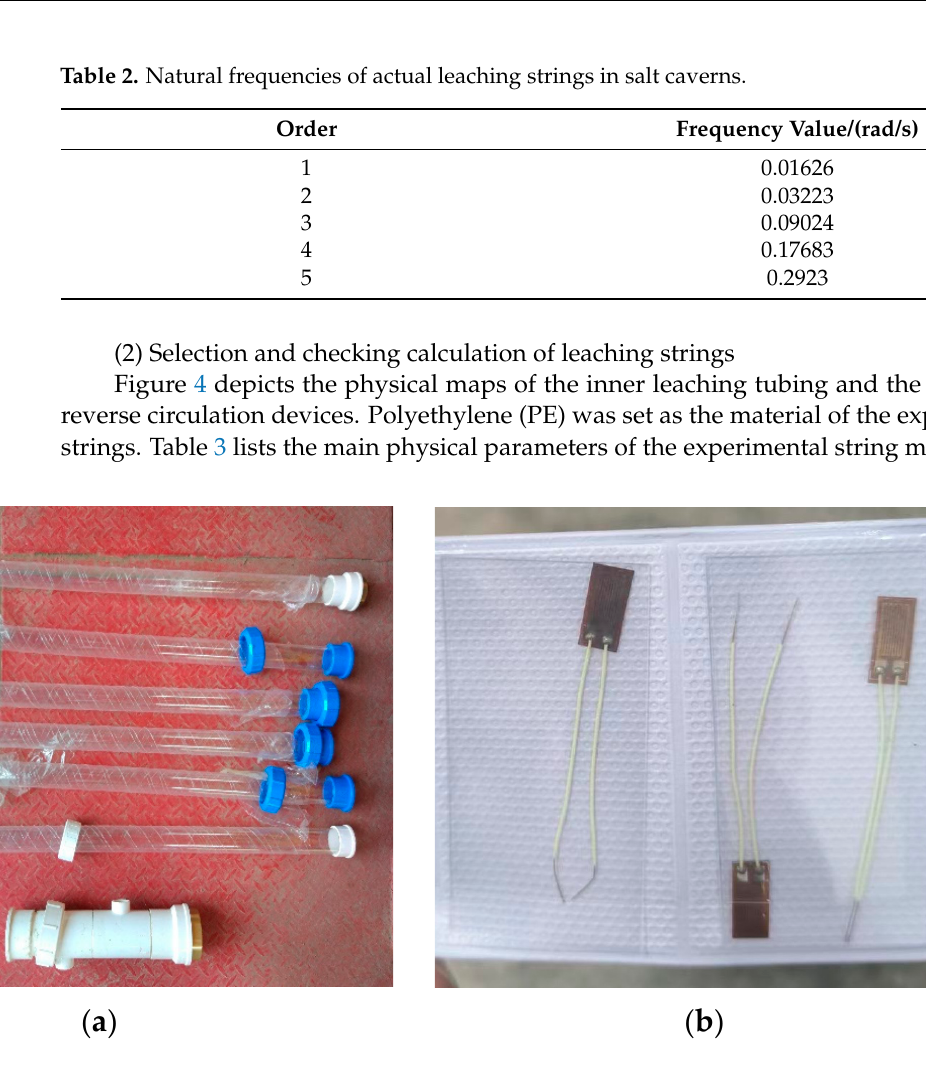
Table 2. Natural frequencies of actual leaching strings in salt caverns.